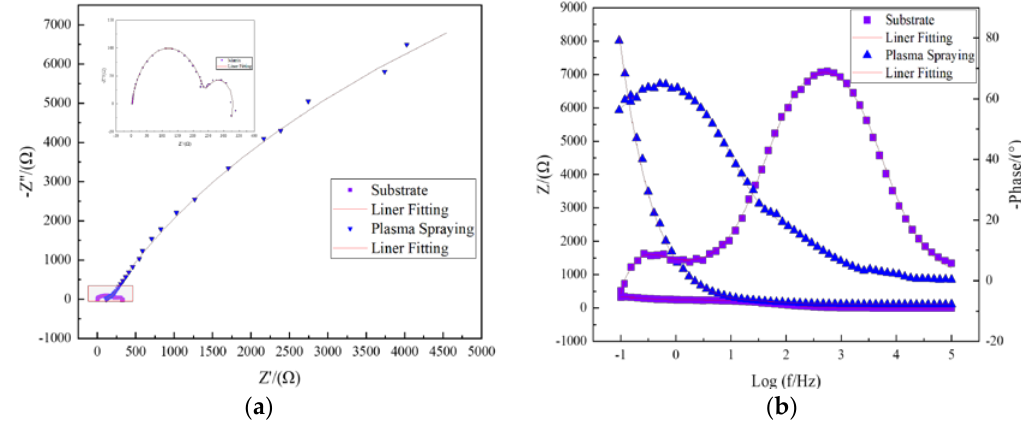
Figure 5. Alternative current impedance spectra and bode diagrams of the VW75 substrate and plasma spraying ceramic layer. ( a ) Nyquist plots; ( b ) Bode plots.